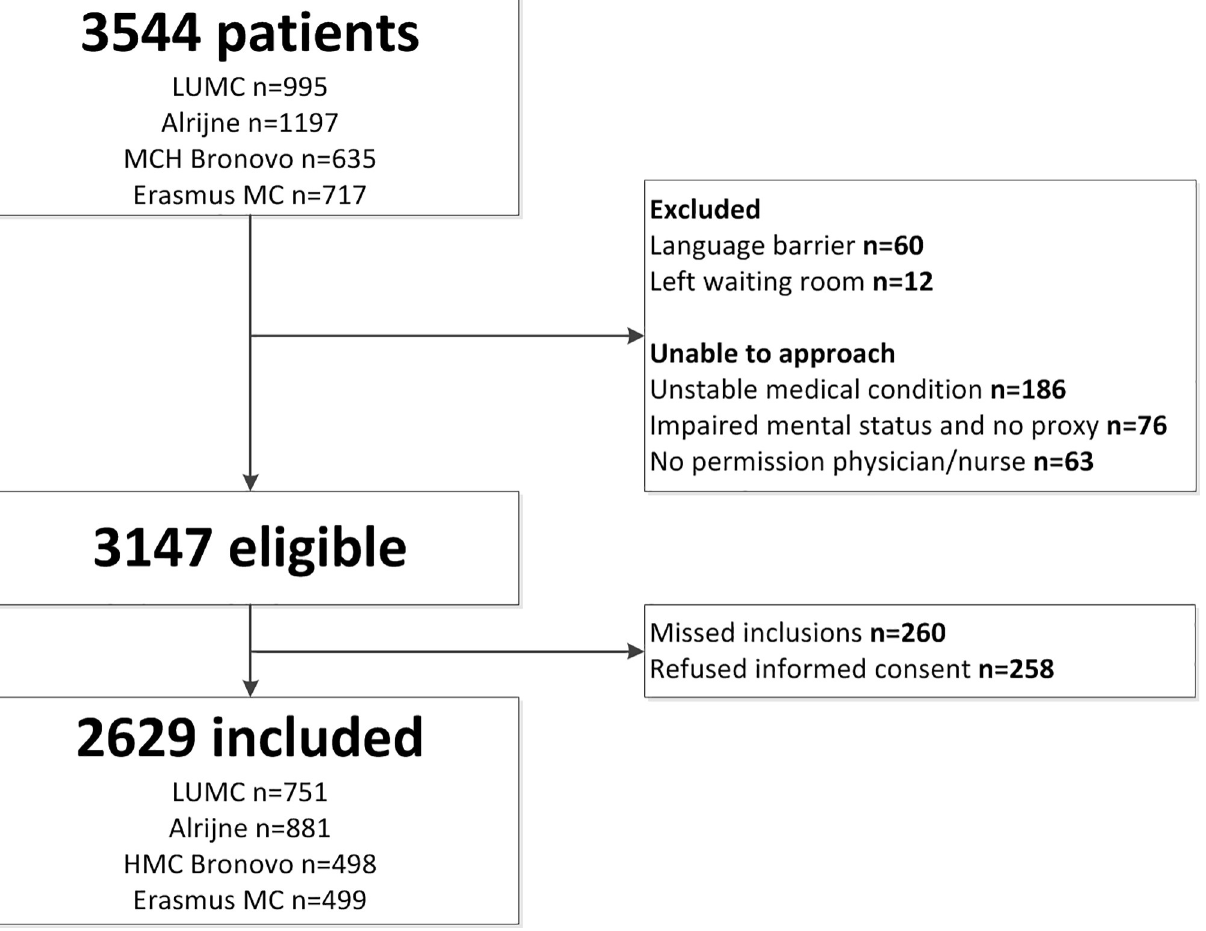
Fig 1. Flowchart of study population. Abbreviations: n =